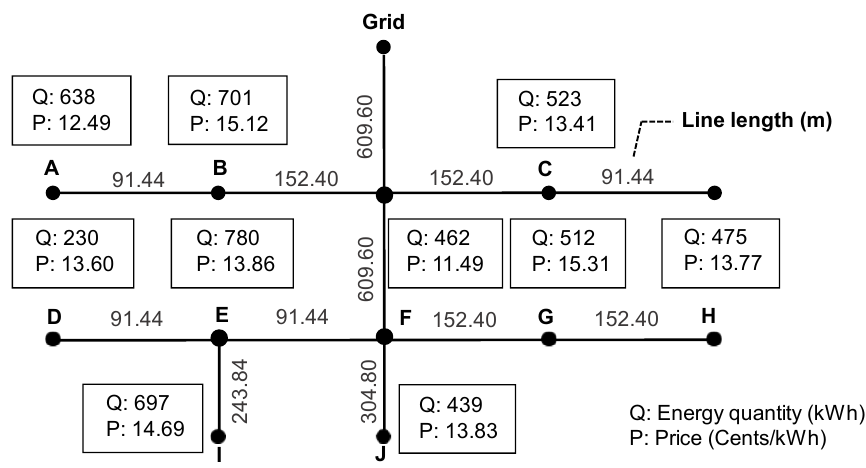
Figure 7 . Information of power quantity, price, and distance between nodes for Case 2 . Figure 7. Information of power quantity, price, and distance between nodes for Case 2. Table 8. Results of transaction: trading energy part after matching process . Table 8. Results of transaction: trading energy part after matching